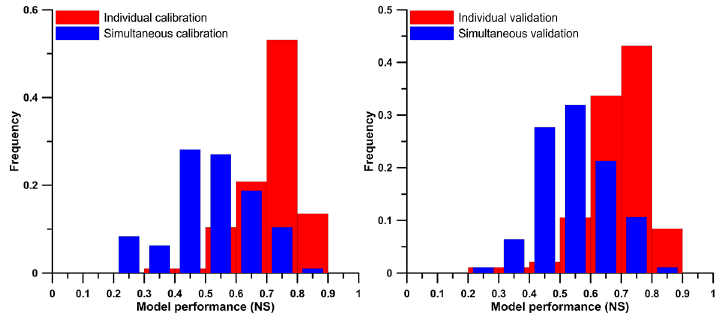
Figure 10. Histograms of the NS model performance of HBV for the 96 selected (donor) catchments. Left panel: calibration period (1971– 1980), right panel: validation period (1991–2000).